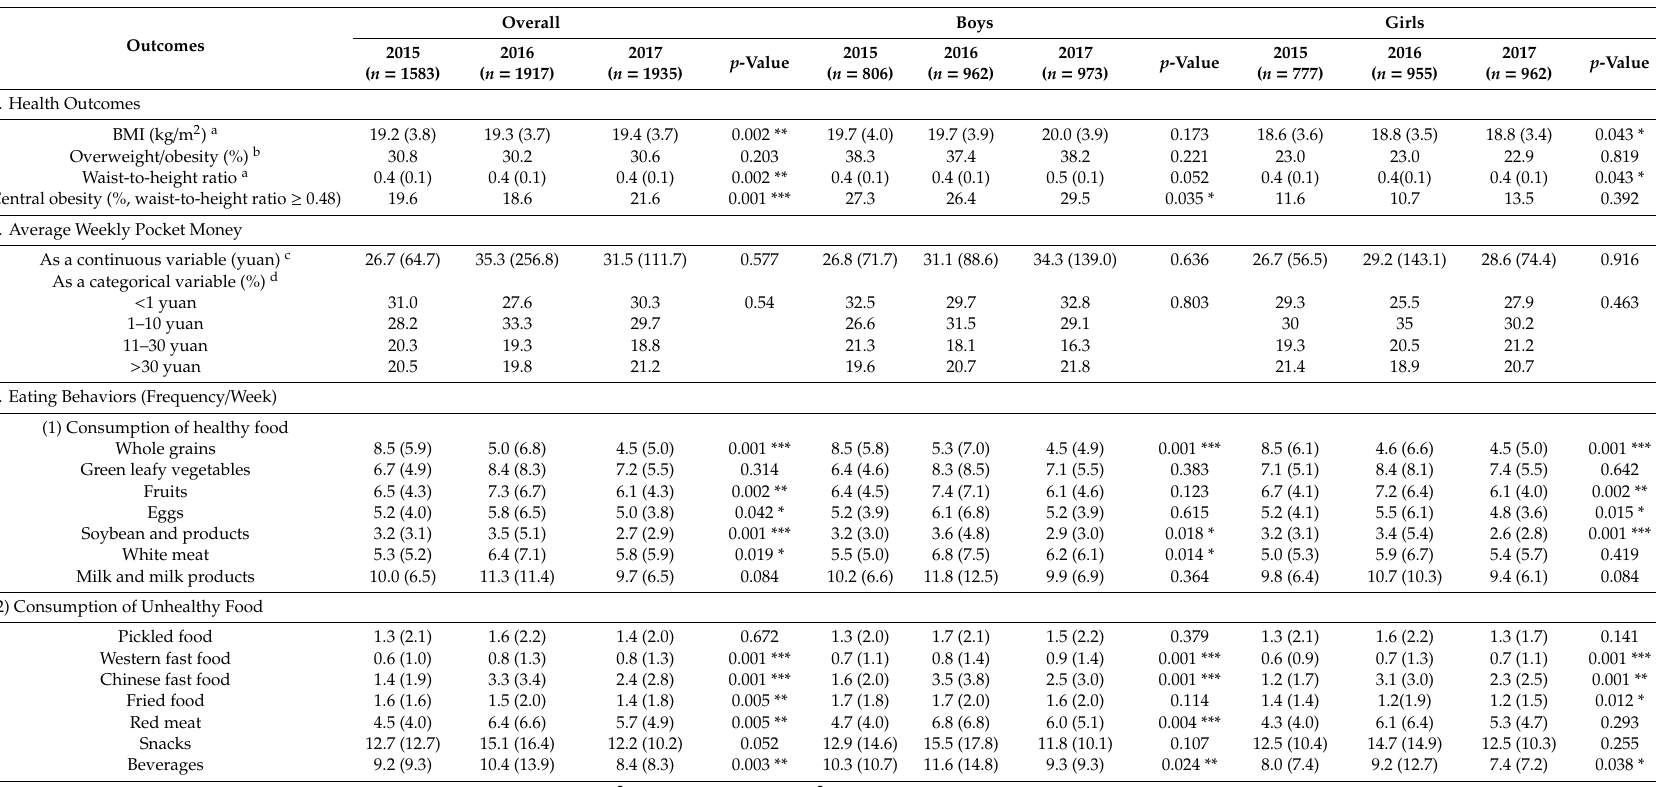
Table 1. Characteristics (mean / standard deviation (SD) or %) of health outcomes, weekly pocket money, and eating behaviors in children: The Childhood Obesity Study in China Mega-Cities, 2015–2017 a